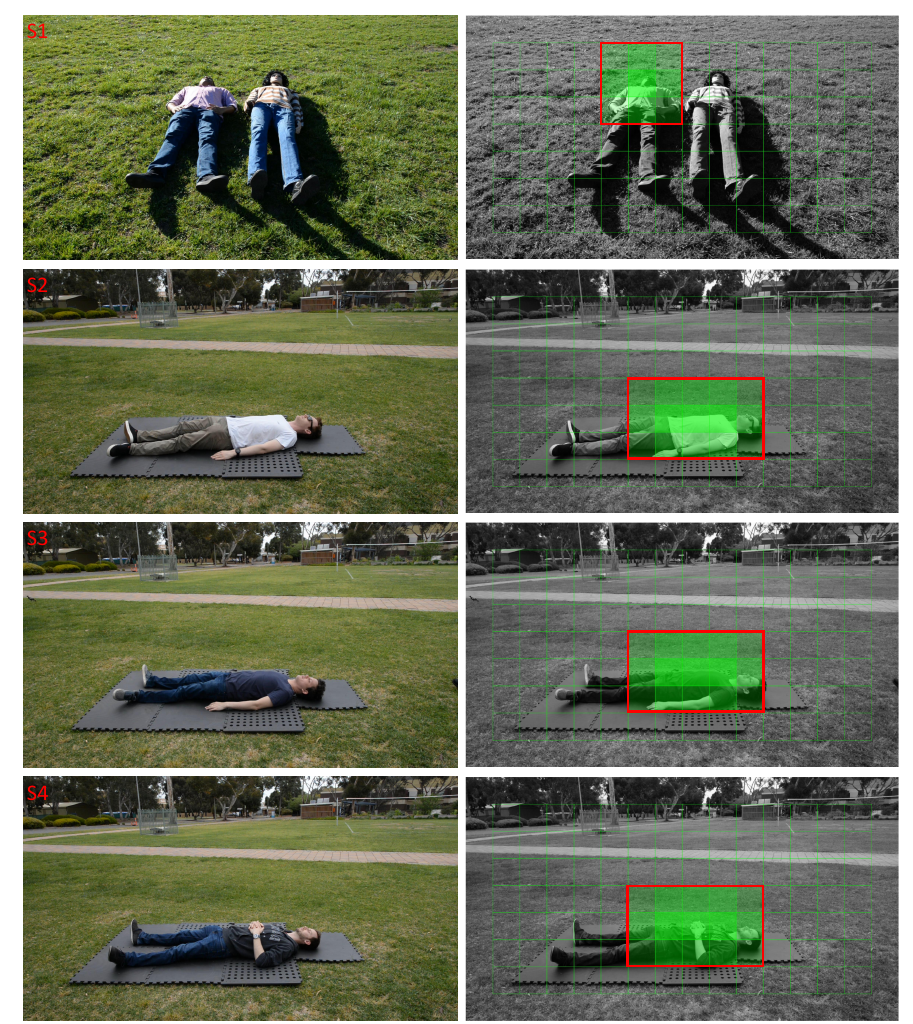
Figure 8. The first column of the images are the first frames of each ground video. The second column of images show their localization maps drawn over the first